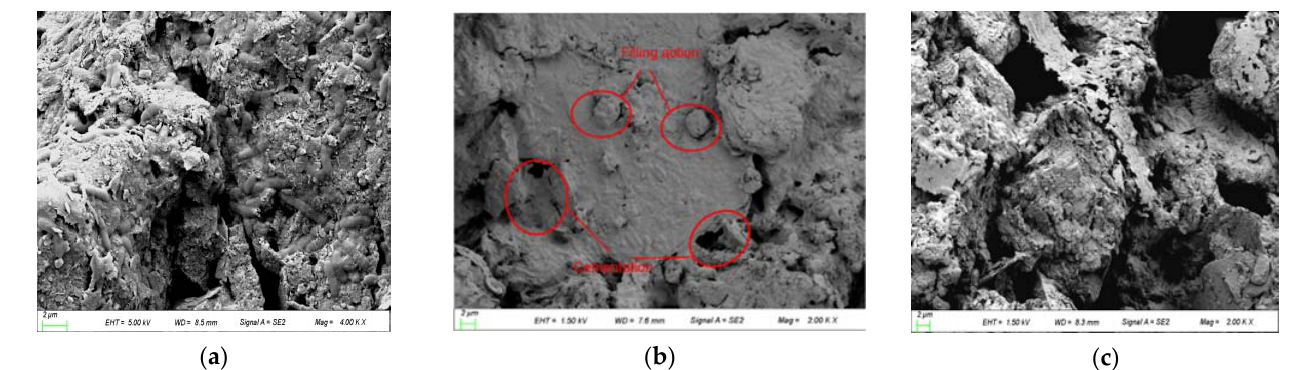
Figure 6. Pore microstructure of loess cured by MICP. ( a ) Loess solidify at 4000 times; ( b ) MICP curing loess mode; ( c ) Loess solidify at 2000 times.